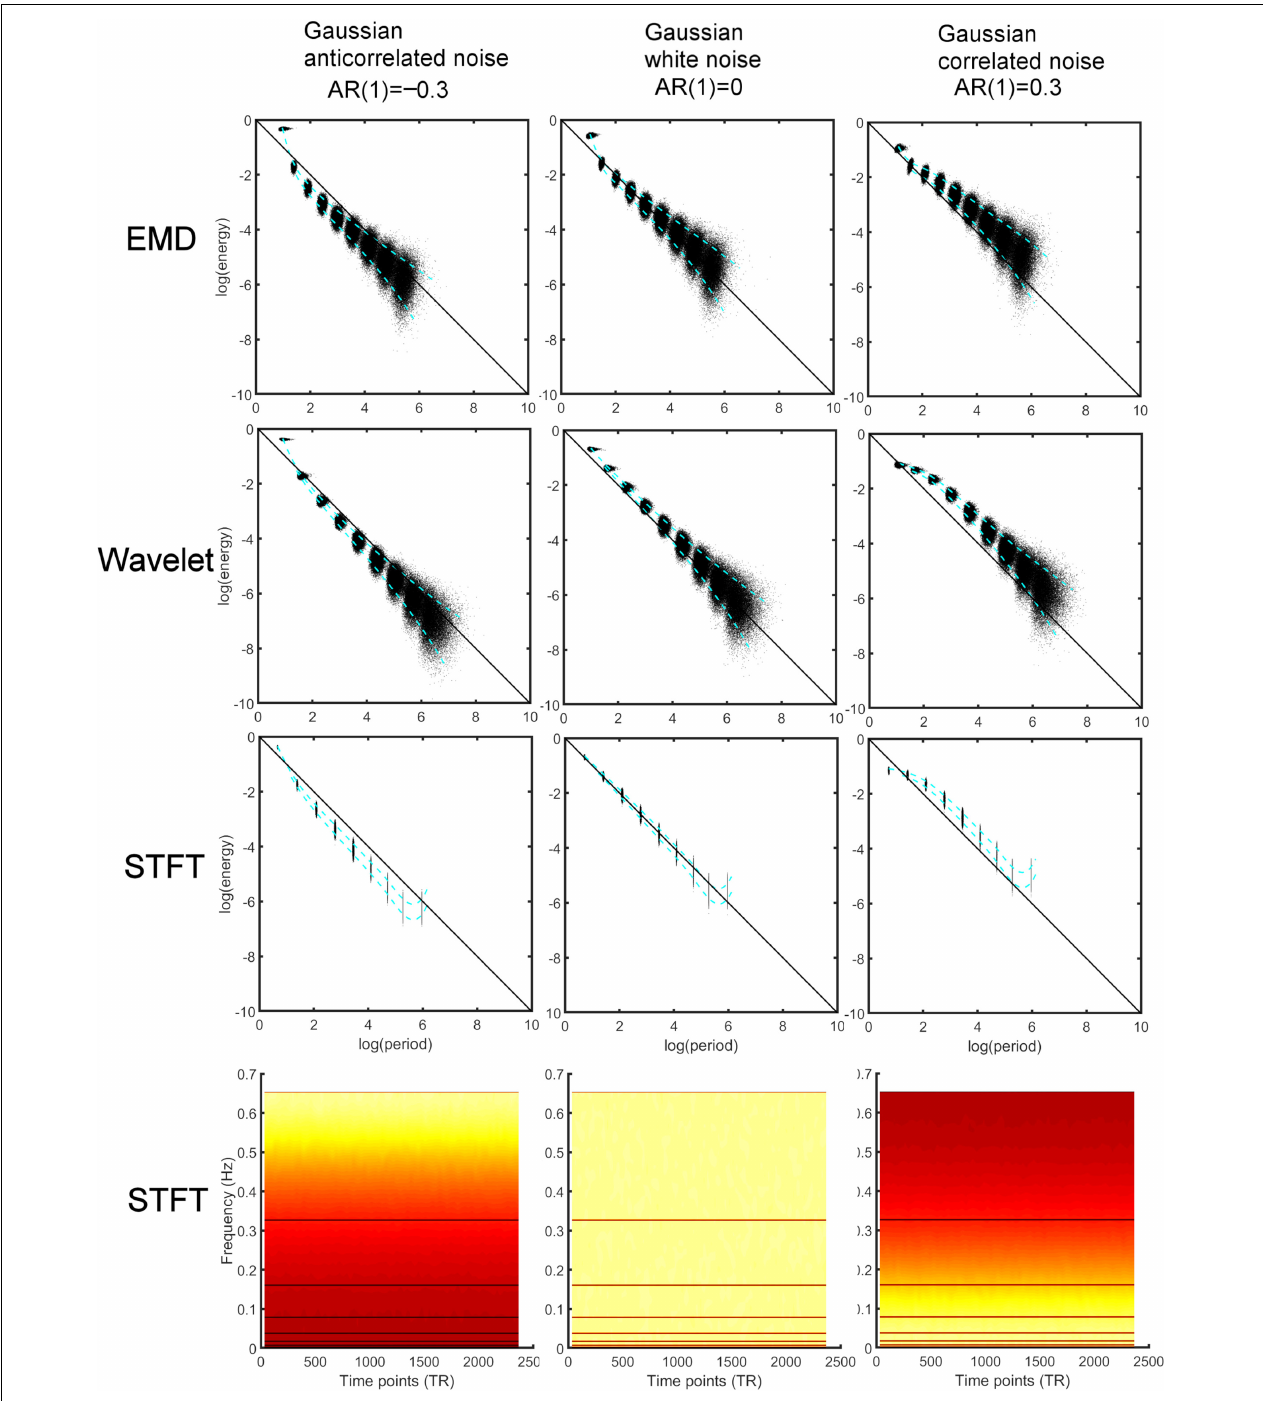
FIGURE 2 | Comparison of energy-period relationship of different noise processes [Gaussian anticorrelated AR(1) noise (left) , Gaussian white noise (middle) , Gaussian correlated AR(1) noise (right) ] for 1000 simulated time series data (TR 0.765 s, 2367 time points). Energy-period information was obtained using different analysis methods. Top : Empirical Mode Decomposition (EMD) determines Intrinsic Mode Functions (IMFs) of which the first 9 IMFs were used to obtain energy-period information. The blue dotted lines represent the 5 and 95% of the energy-period distribution for all IMFs. Second from top : The Maximal Overlap Discrete Wavelet Transform (MODWT) leads to similar energy-period profiles for the first nine detail functions. Third from top : Energy-period relationship in dyadic frequency bands determined by the Short-Time Fourier Transform (STFT). Bottom : Spectrogram using the STFT. The horizontal lines indicate the different dyadic frequency bands. Hot (yellow) color indicates larger intensity (energy). The larger frequency bands have larger energy content. Note that a negative AR(1) process leads to high-frequency noise whereas a positive AR(1) leads to low-frequency noise indicated by the yellow color.